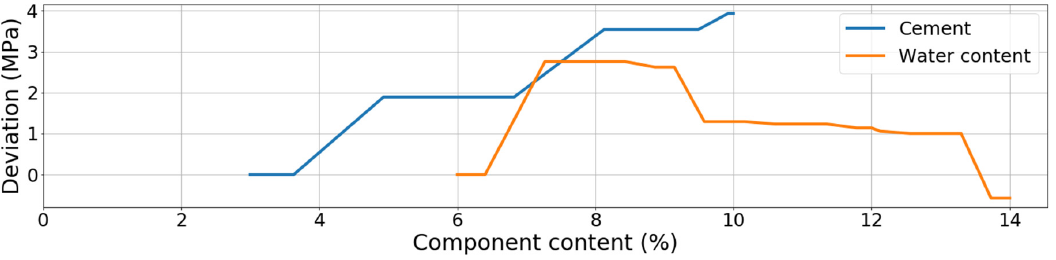
Figure 9. ALE plots for cement and water content based on DTR.